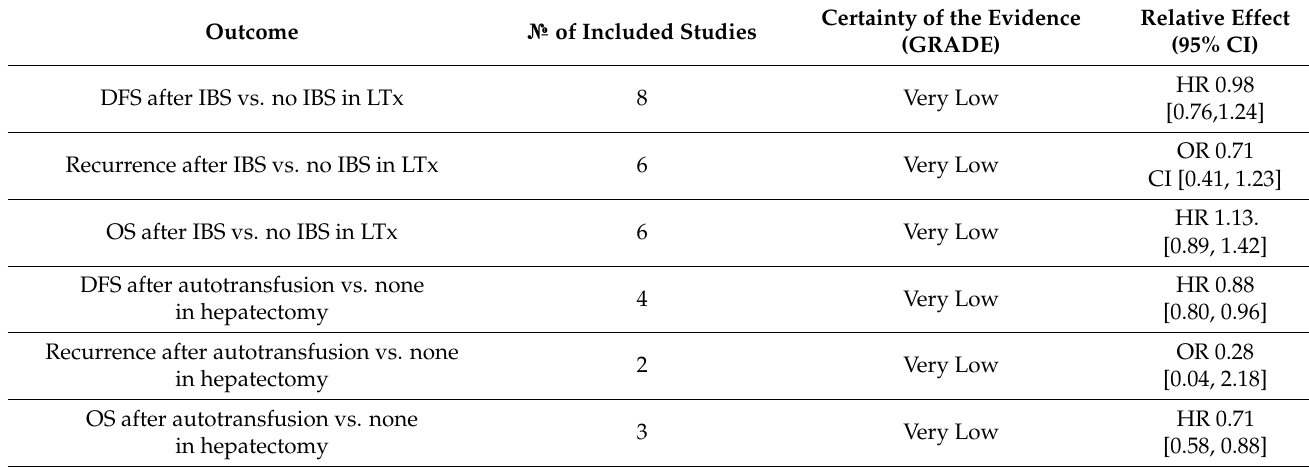
Table 5. Certainty of evidence for assessed